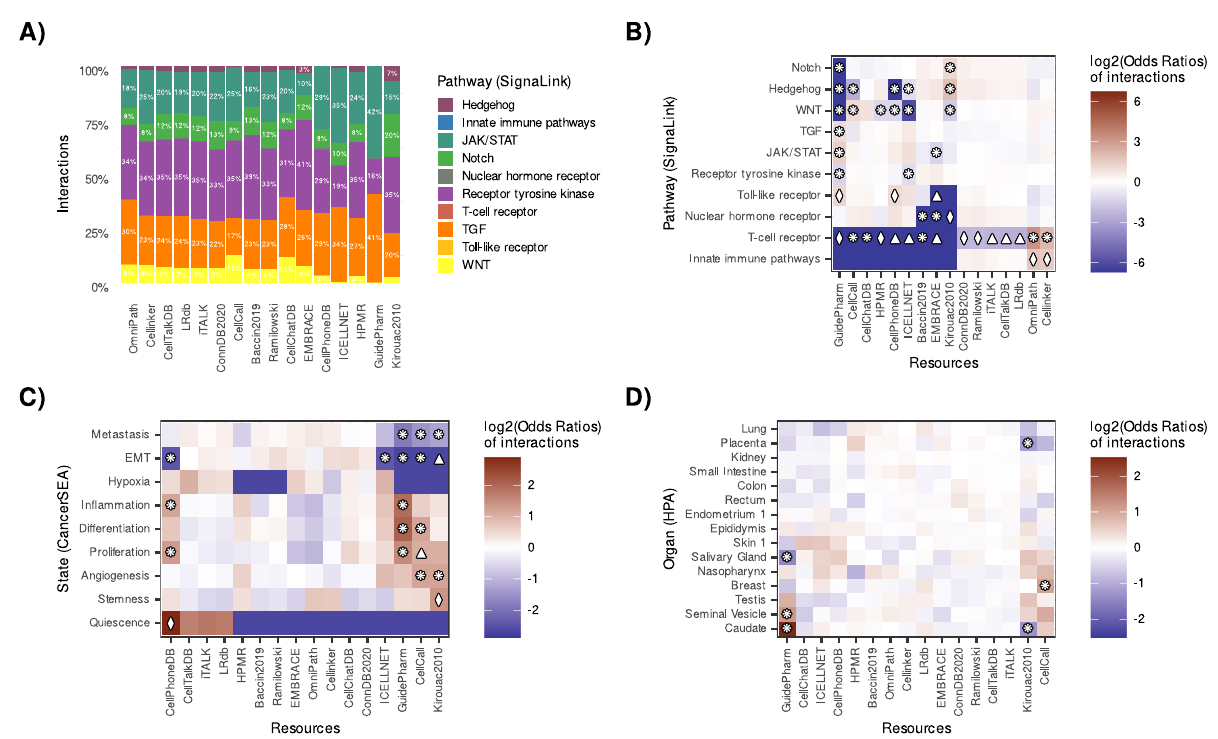
Fig. 4 Representation of functional categories in CCC resources. CCC resources distributions in terms of number of interactions ( A ) and relative abundance ( B ) matched to the SignaLink database. Relative abundance of interactions categorised by ( C ) CancerSEA ’ s cancer-related gene sets, and ( D ) organ-enriched proteins from the Human Protein Atlas (HPA). Fisher ’ s exact test was used to estimate the differentially-represented categories. Differentially represented (absolute(log2(Odds ratio)) >1) categories were marked according to FDR-corrected p -values = < 0.05 (diamond, ♢ ), 0.01 (triangle, △ ), and 0.001 (8-pointed asterisk; ❋ ). Source data are provided as a Source Data fi